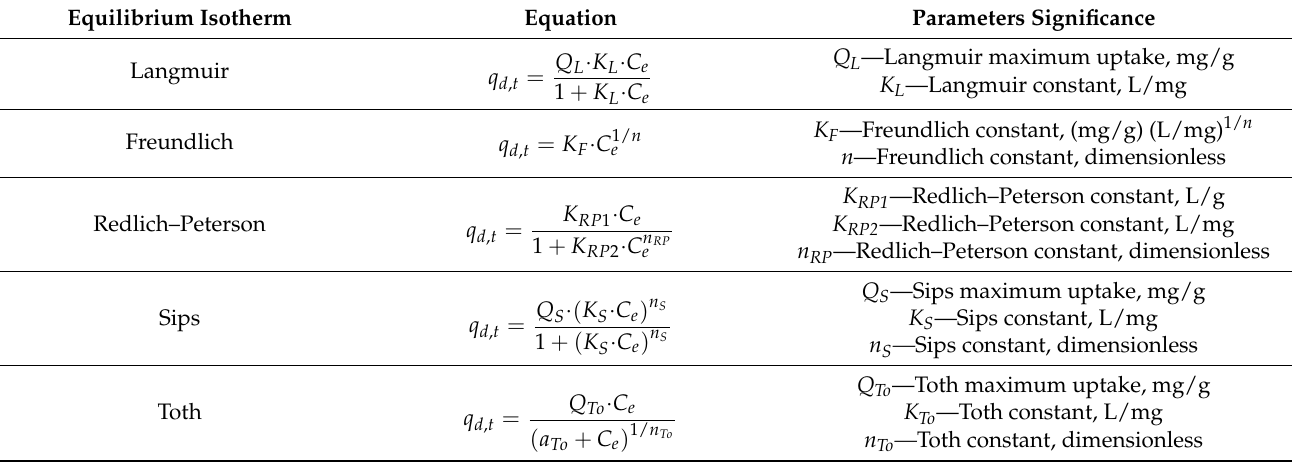
Table 6. Desorption equilibrium isotherms nonlinear